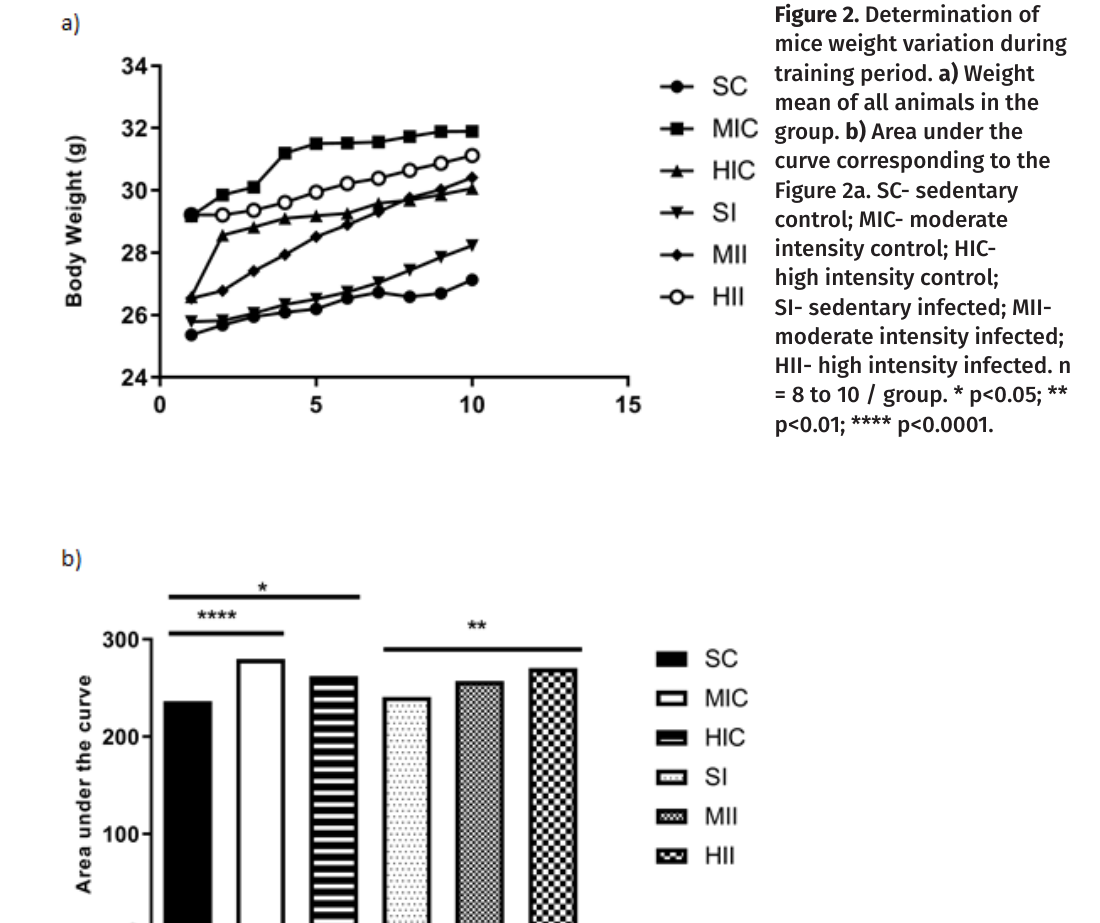
Figure 2. Determination of mice weight variation during training period. a) Weight mean of all animals in the group. b) Area under the curve corresponding to the Figure 2a. SC- sedentary control; MIC- moderate intensity control; HIC- high intensity control; SI- sedentary infected; MII- moderate intensity infected; HII- high intensity infected. n = 8 to 10 / group. * p<0.05; ** p<0.01; ****